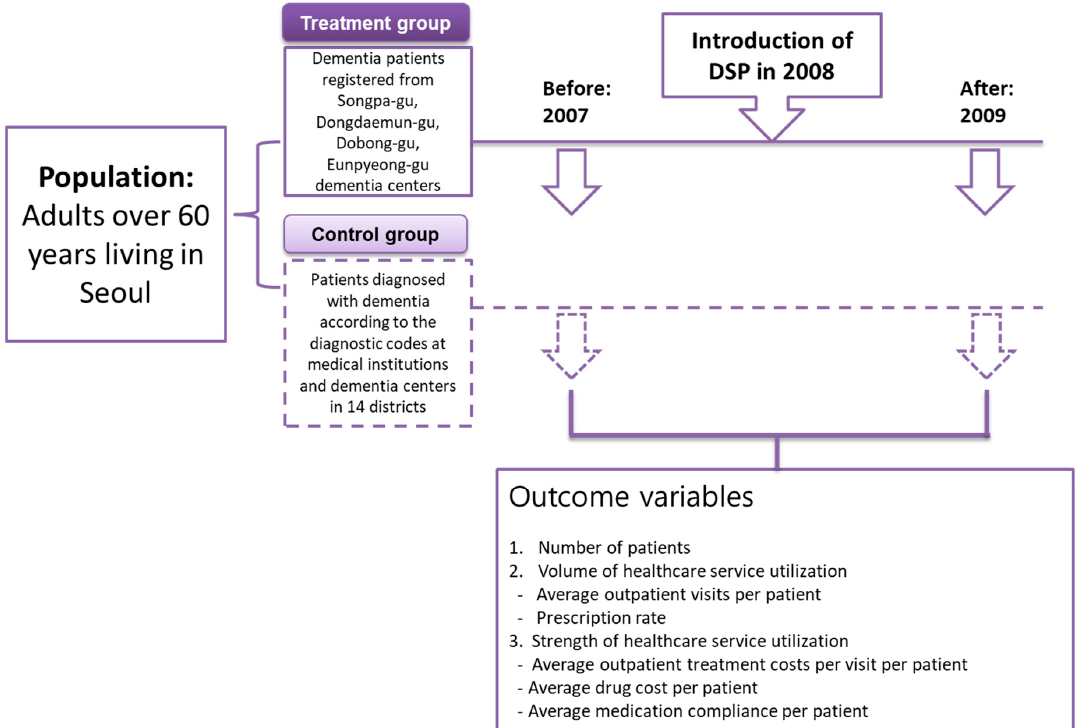
Figure 1. Overview of study design to evaluate the effects of the introduction of a dementia screening program (DSP).